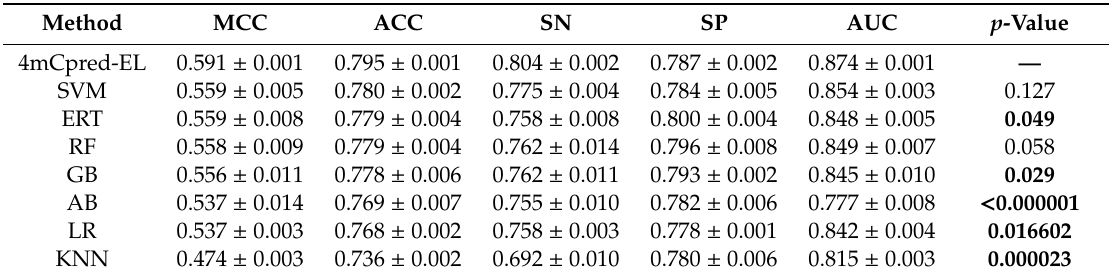
Table 1. Evaluation assessment between our proposed method and individual classifiers based on a benchmark set.